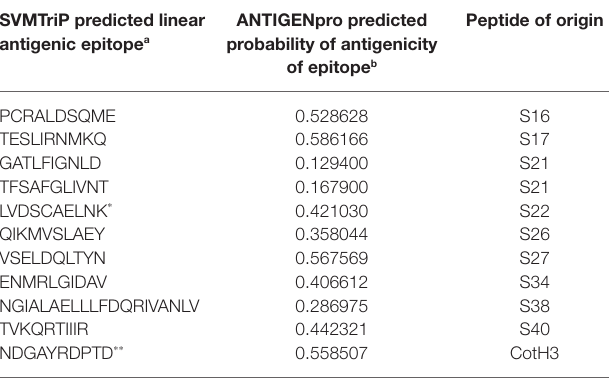
TABLE 4 | In silico prediction of linear antigenic epitopes and the probability of antigenicity originated from peptides showing predictive extracellular localization. SVMTriP predicted linear antigenic epitope